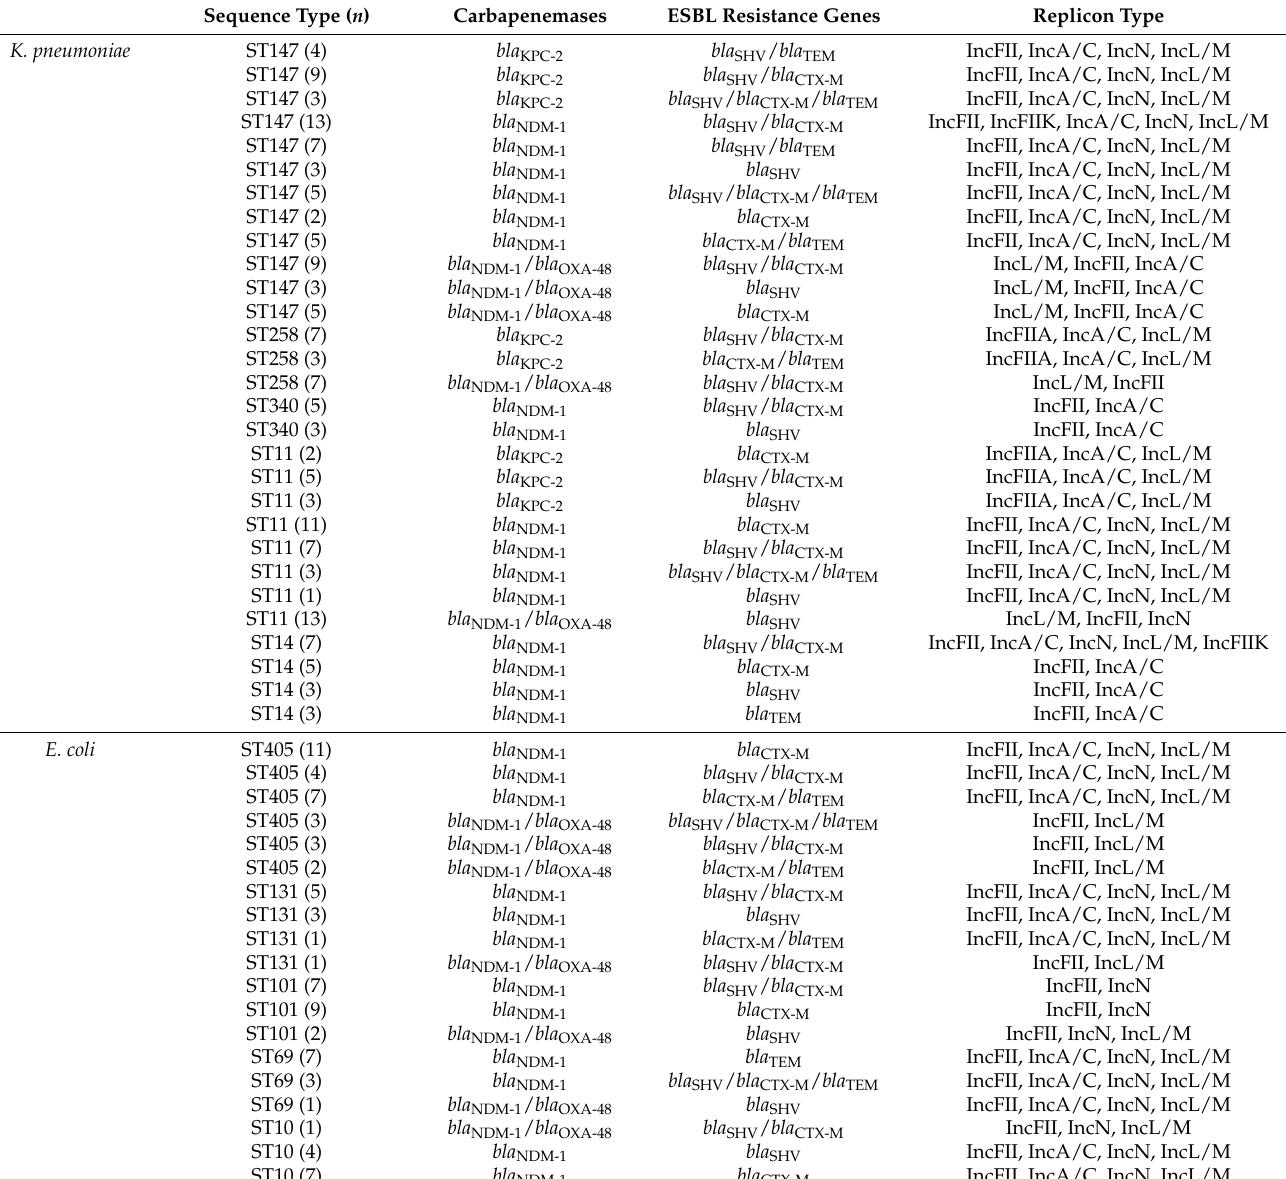
Table 6. Genetic profile of carbapenemase-positive